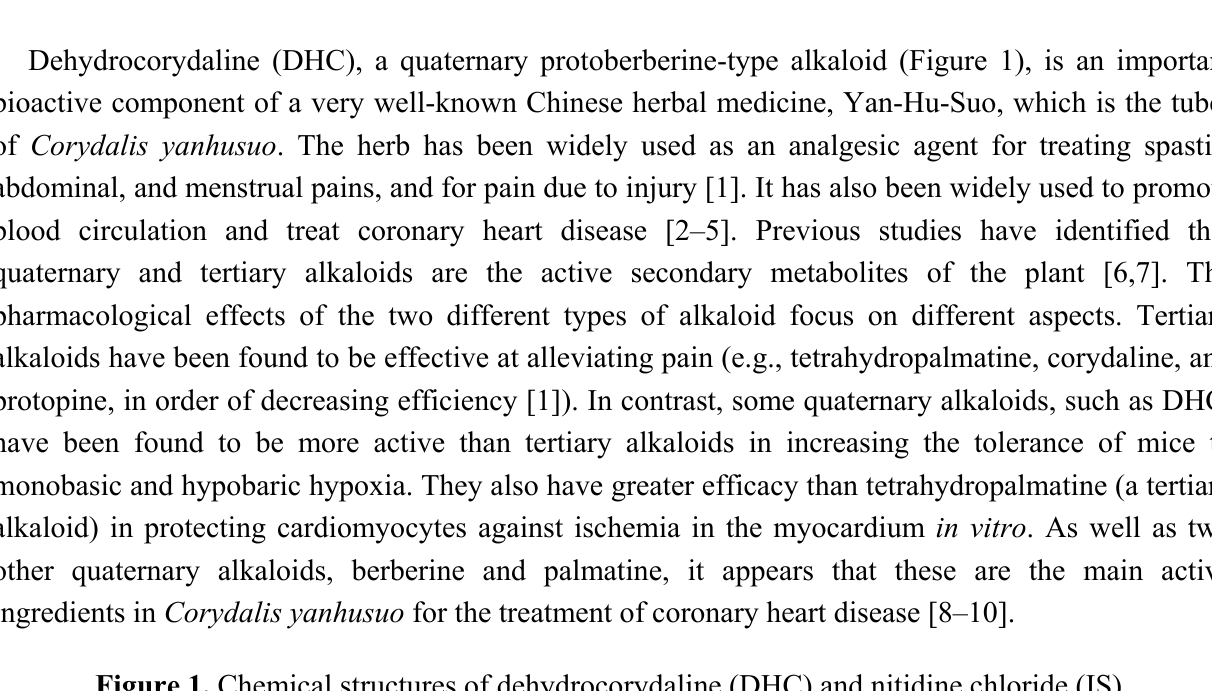
Figure 1. Chemical structures of dehydrocorydaline (DHC) and nitidine chloride